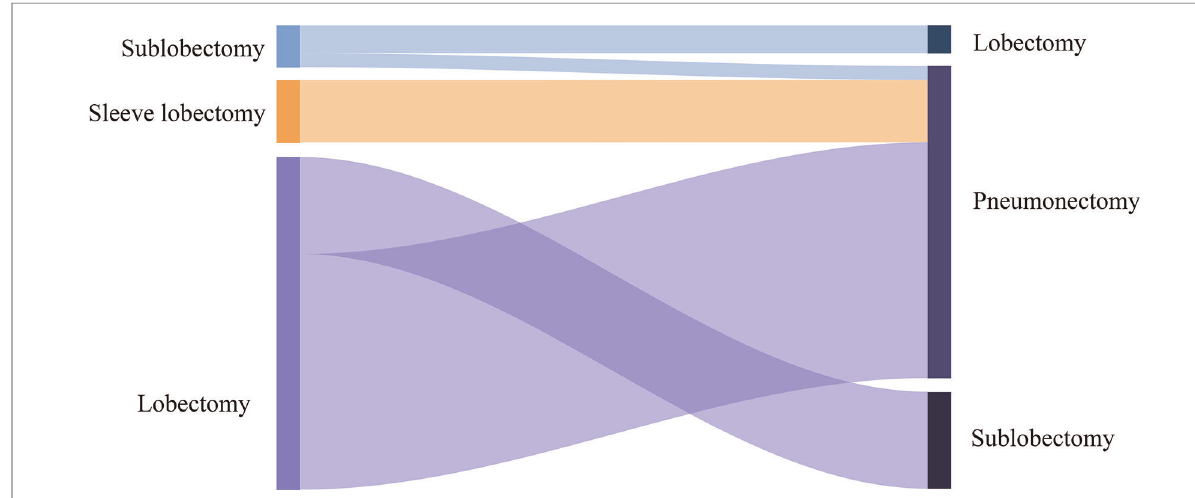
FIGURE 2 Sankey diagram of primary and completion surgery methods.